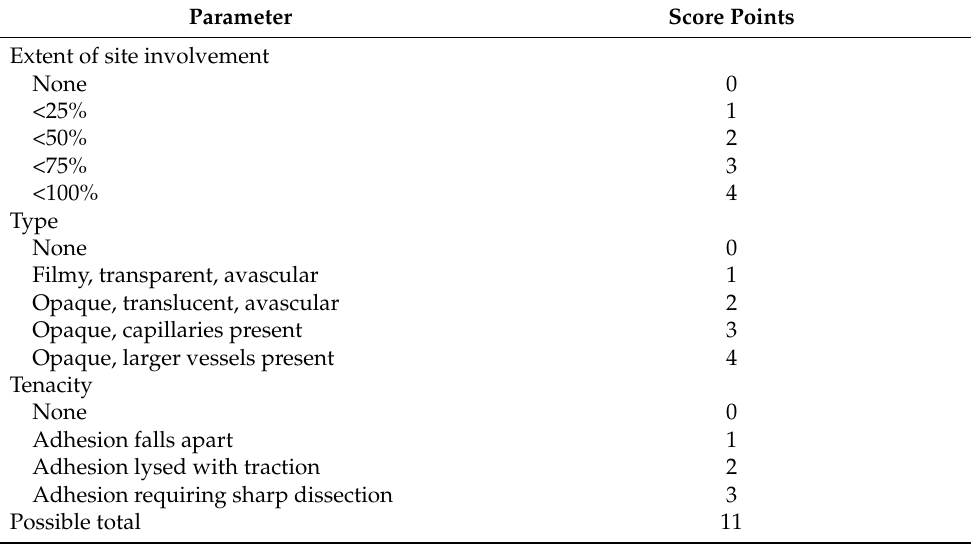
Table 2. Peritoneal adhesion score created according to Diamond et al. [15]. Parameter Score